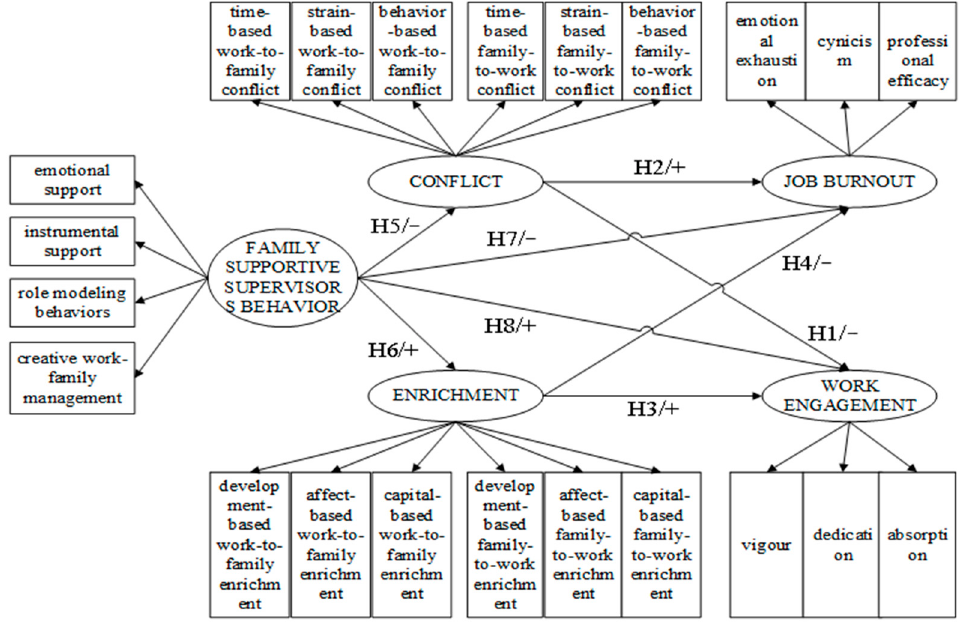
Figure 1. Hypothetical model.